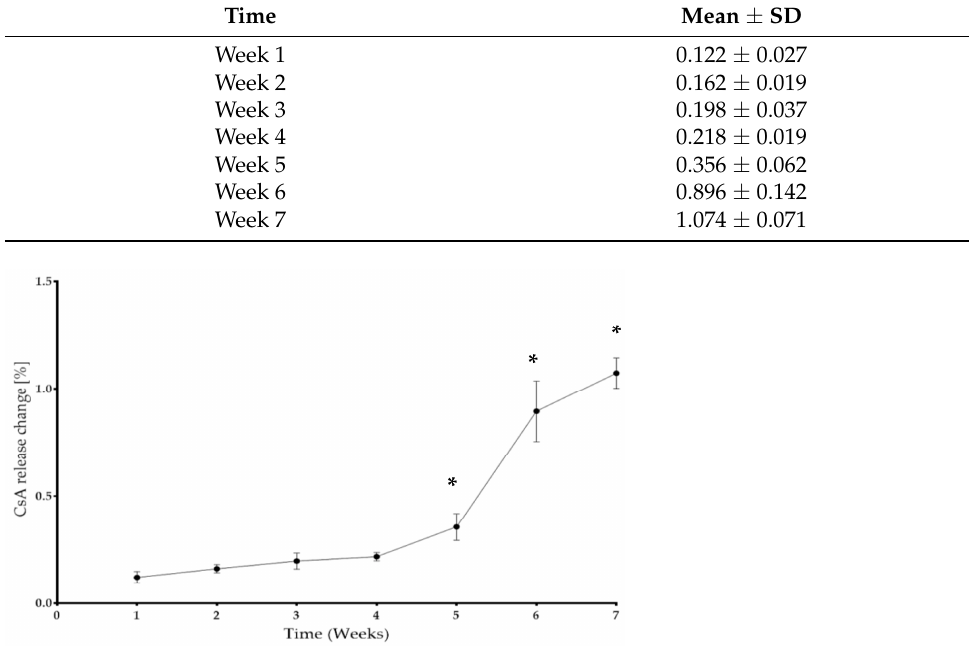
Figure 3. The cyclosporin A released from the matrix (PLDLA 90% + TPU 10%) over 7 weeks. Data points in the line plots were calculated based on the mean values of five replicates for each week interval with standard deviation error bars. In the boxplot: whiskers = 1.5 × IQR, lines = average; boxes = interquartile range Q1–Q3. * Adjusted p value < 0.05 and significant difference from all